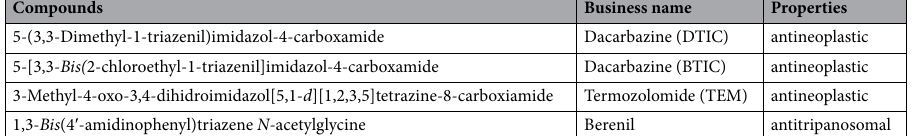
Table 1. Diaryltriazene derivatives with biological activities.